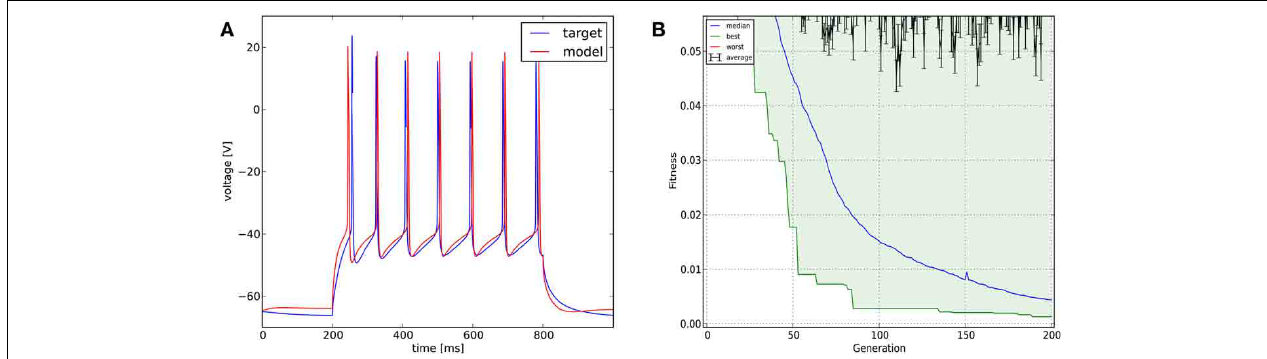
FIGURE 6 | The results of Optimizer on Use case 3 (fitting voltage traces from a detailed compartmental model). Figure layout and notation are similar to Figure 4